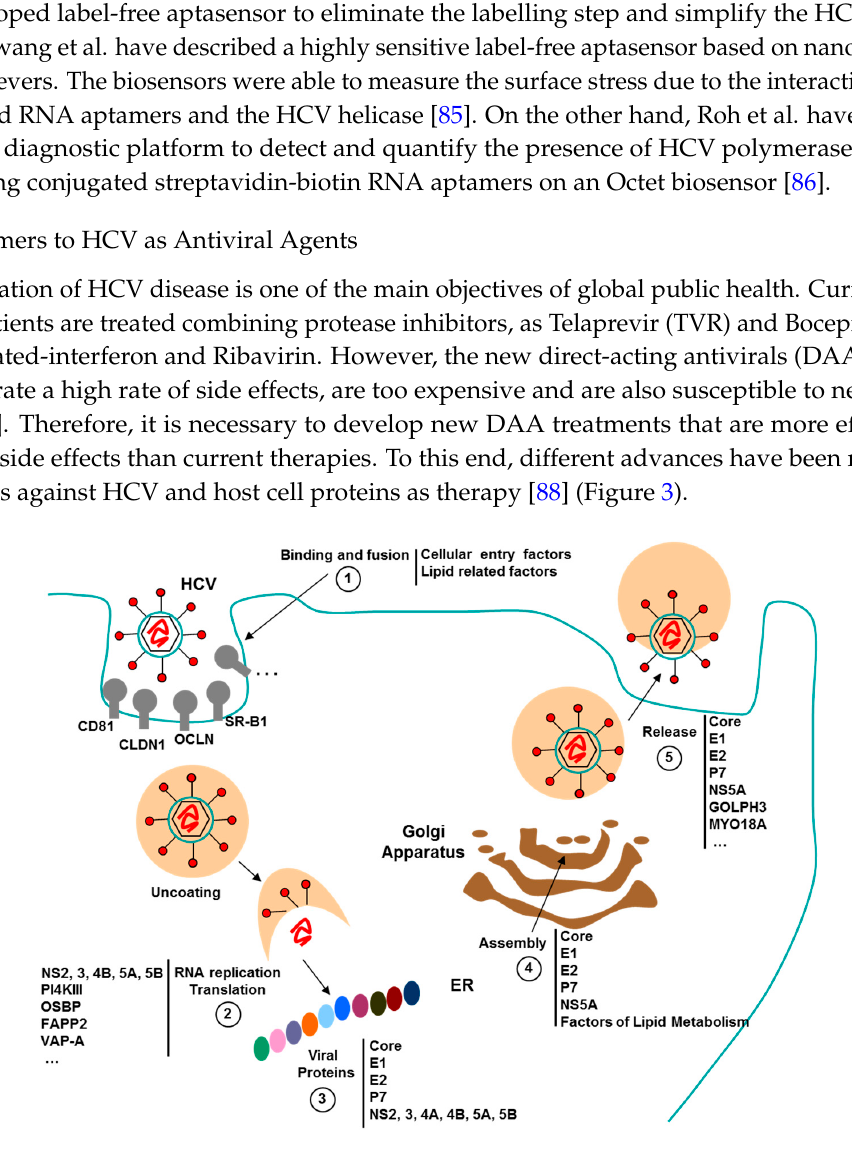
Figure 3. Scheme of Hepatitis C viral cycle showing the targets for aptamers. ( 1 ) Cellular entry factors and lipid related factors have been identified as important targets for aptamer selection, to avoid binding and viral fusion of HCV virus; ( 2 ) In the steps of RNA replication and translation several host factors as PI4KIII, OSBP or FAPP2 are candidates for aptamer selection; ( 3 ) HCV RNA genome encode for ten viral proteins, however until the date there are aptamers selected against seven of them; ( 4 ) Factors of lipid metabolism mediate viral assembly and can be chosen as targets for antiviral therapy; ( 5 ) Proteins and factors implicated in viral release are crucial for viral propagation and can be used for aptamer selection. Endoplasmic reticulum (ER).